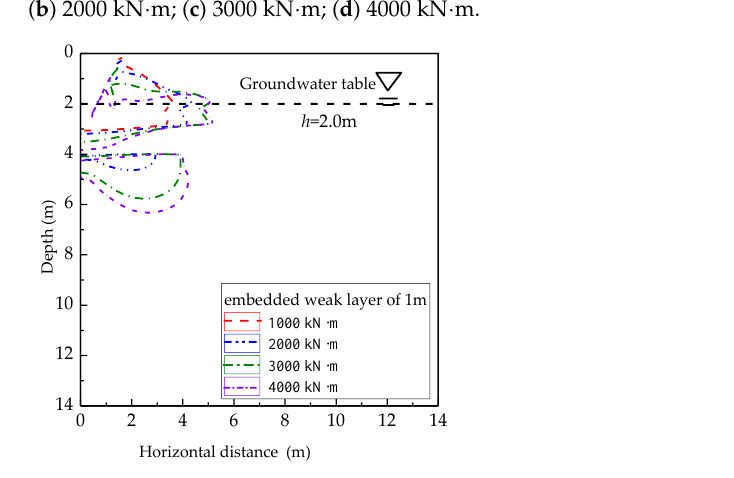
Figure 17. Cloud lines of I r = 7.7% of embedded weak layer for different tamping energy. Figure 18 shows that the excess pore pressure ratio in the upper soil of the weak layer was close to 0 after 10 blows due to its high permeability, the soil in which the layer was effectively reinforced. For the embedded weak layer, the dissipation of pore pressure was not obvious, and the excess pore pressure ratio reached its maximum values, increasing significantly with increases of the tamping energy. If the tamping energy was too large, the dissipation of excess pore pressure of soil would be incomplete, especially in the soft